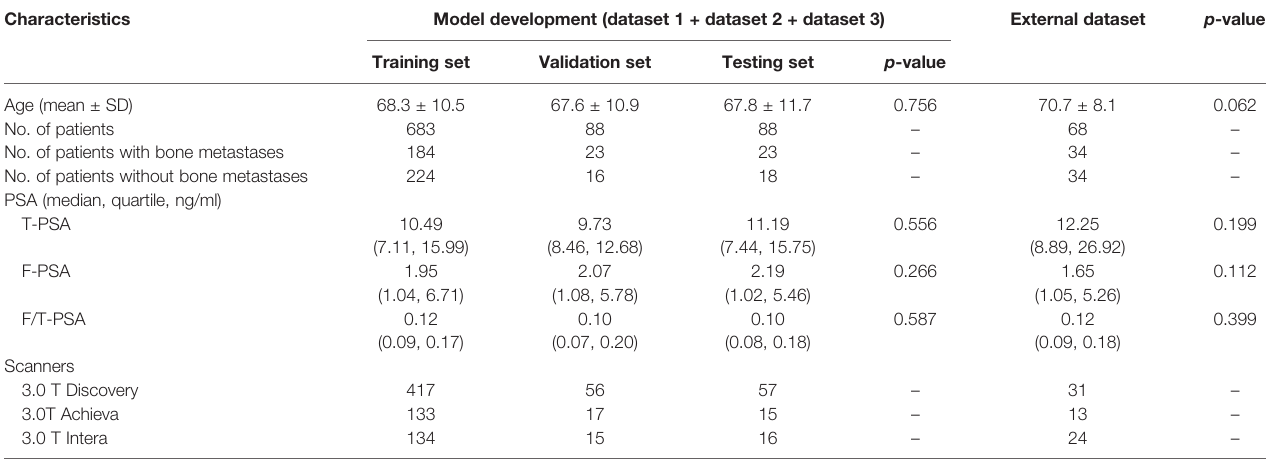
TABLE 2 | Characteristics of patients for the pelvic bony structure segmentation model.